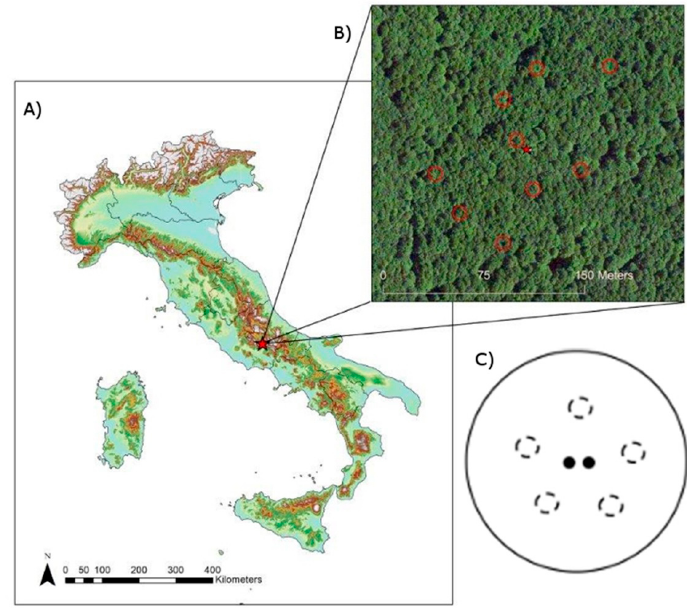
Figure 1. ( A ) Location of the Selva Piana experimental site. ( B ) Spatial distribution of the nine experimental plots (red circle) within the experimental site (the star identifies the location of the flux tower). ( C ) Schematic representation (not to scale) of the 5 m radius experimental plot (solid line), including the 5 soil CO 2 efflux (SR) collars (dashed circle) and the 2 ingrowth cores (black filled circle).